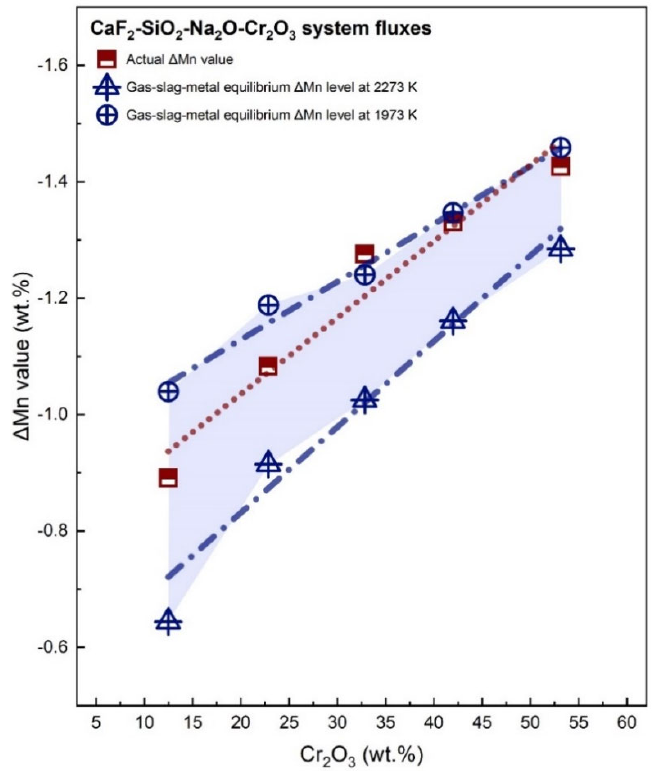
Figure 6. Actual and predicted Δ Mn levels as a function of the Cr 2 O 3 addition level in the